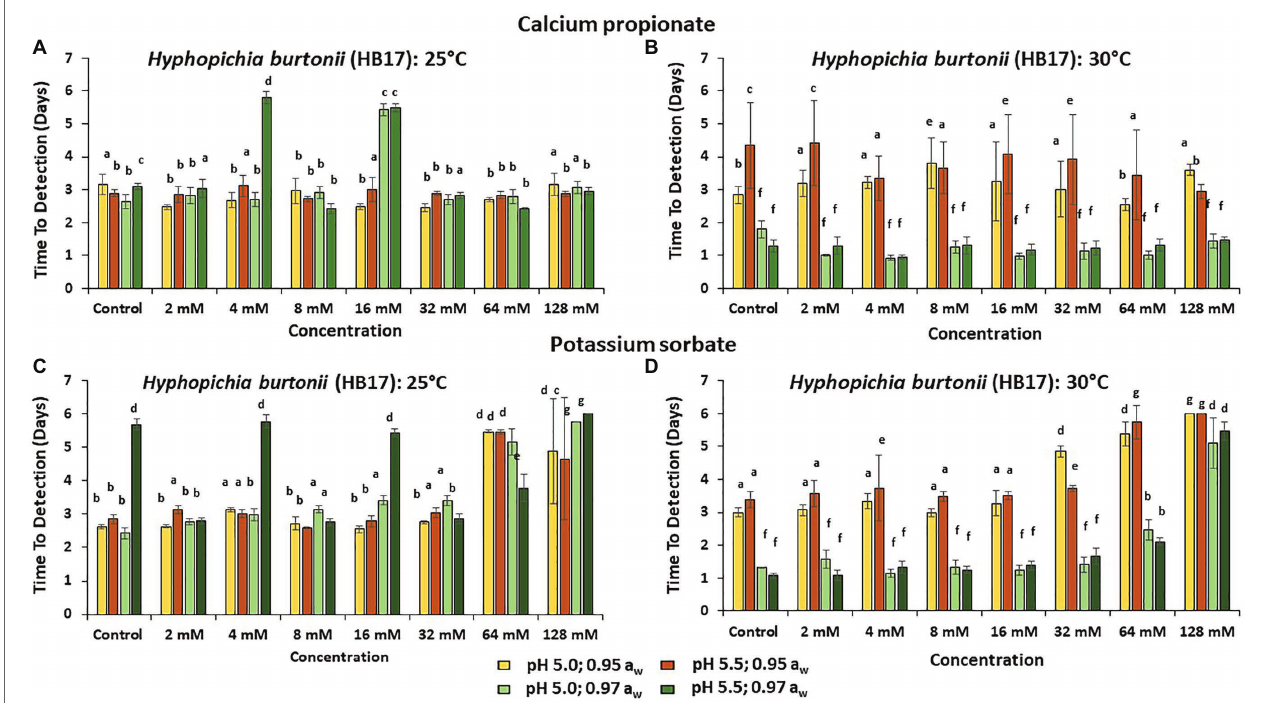
FIGURE 3 | The Time to Detection (TTD; OD = 0.4 OD; 6 days) of HB17 at (A) 25 ° C and (B) at 30 ° C in the presence of different concentrations of CP; and for PS at (C) 25 ° C and (D) 30 ° C. Bars represent the SEM. Treatments with different letters are significant ( p =